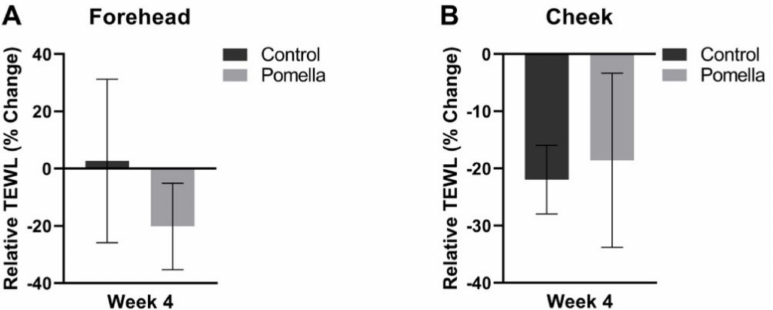
Figure 4. Transepidermal water loss (TEWL) in the Control and PE groups relative to pre-treatment baseline. The TEWL at 4 weeks was compared against baseline on the forehead ( A ) and the cheeks ( B